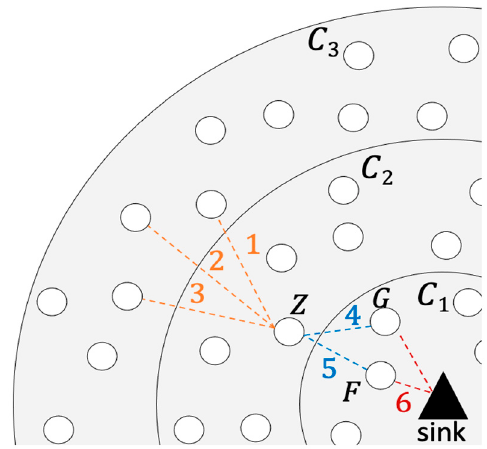
Figure 9. Channel assignment for nodes in C 1